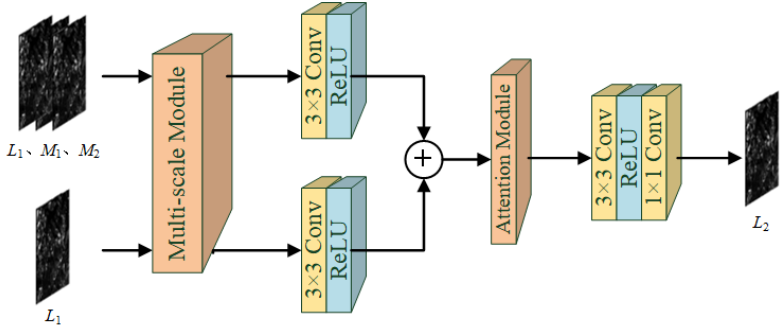
Figure 2. Network architecture